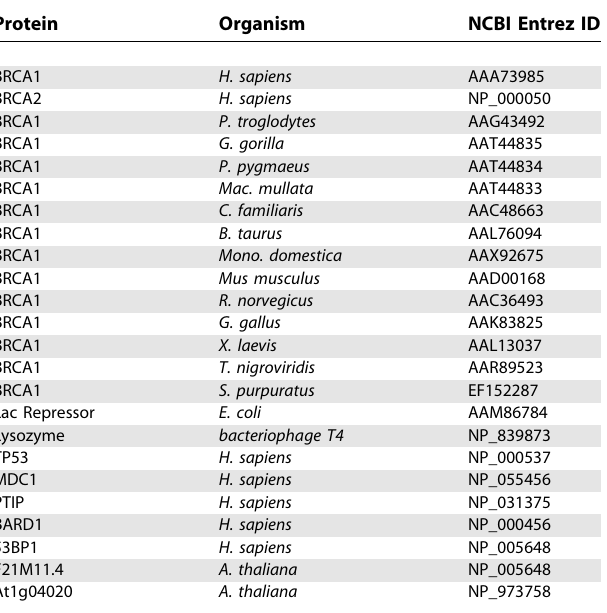
Table S1. Post-Prediction Analysis of BRCA1 BRCT Missense Variants Characterized by Transactivation Assays Transcription assay in yeast (Y) or mammalian (M) cells. We used a 50% activity cutoff value. * , neutral/low clinical relevance; (cid:4) , deleterious/high-risk variant; red, variant names are colored red if classification considering both yeast and mammalian assays is deleterious/high-risk, blue, variant names are colored blue if classification considering both yeast and mammalian assays are neutral/low clinical relevance. There is no available post-prediction analysis for S1715R, T1720A, and P1806A. Table S2. Structural Explanations for the Impact of BRCA1 BRCT UCVs Found in BIC (Excluding Those in Table S1 and Those for Which Definitive Genetic Evidence Exists) Consensus Classification is majority vote of Random Forest, Naı¨ve Bayes, and Support Vector Machine classifiers. Red, deleterious; blue, neutral. Table S3. Core Set of 13 Predictive Features Identified Using a Mutual Information Analysis The mutual information between each feature and the functional/ nonfunctional class of each TP53 missense mutant was computed as described previously [24]. Table S4. Predictive Features of Missense Mutants That Were Tried but Failed To Improve Support Vector Machine Performance on the TP53 Training Set These were not included in the optimal 16 features selected for use with the supervised learning algorithms.